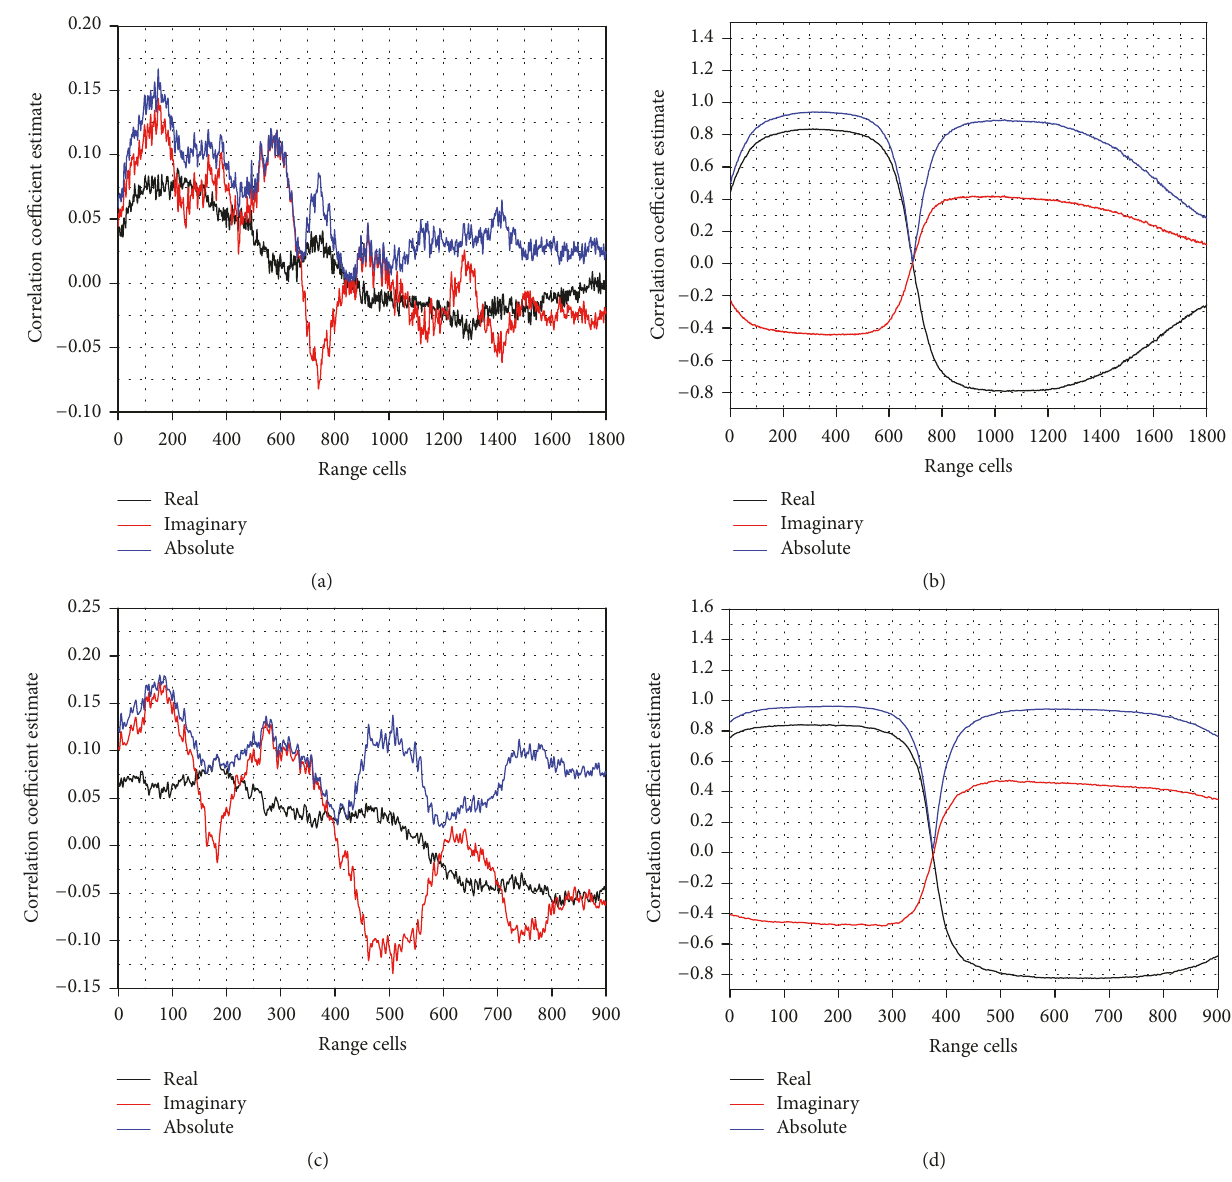
Figure 19: The speckle cross-correlations between the difference and the sum channel for DS1 and DS2: (a) Azimuth direction for DS1. (b) Elevation direction for DS1. (c) Azimuth direction for DS2. (d) Elevation direction for DS2.